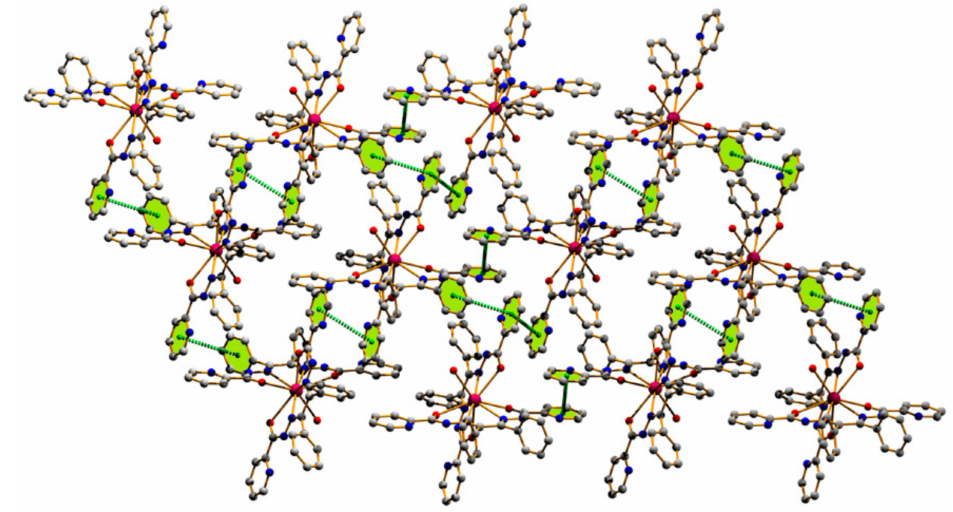
Figure 8. Self-assembled supramolecular network in ( 3 ) through π - π stacking in (011)